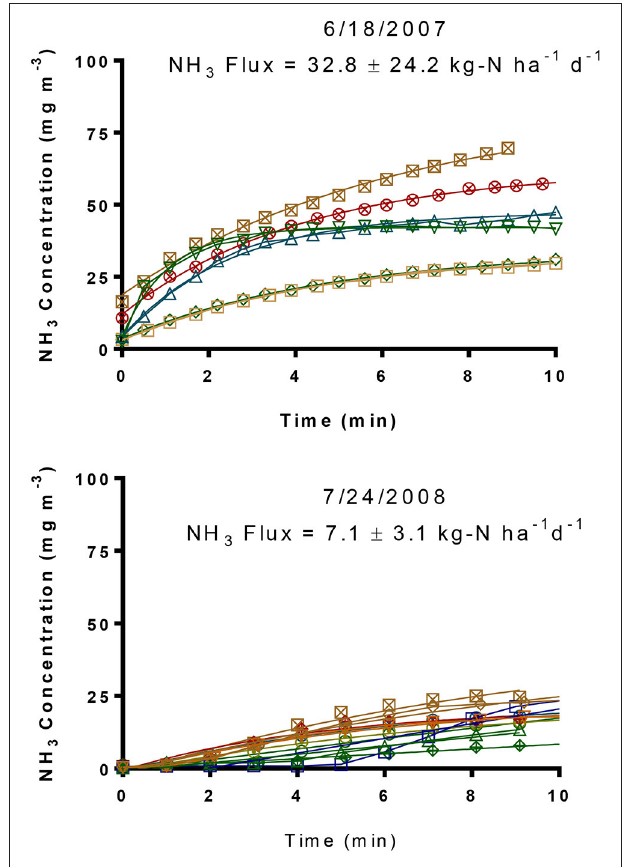
FIGURE 4 | Floating flux chamber headspace NH 3 concentrations from two treatment lagoons in summer 2007 and 2008.